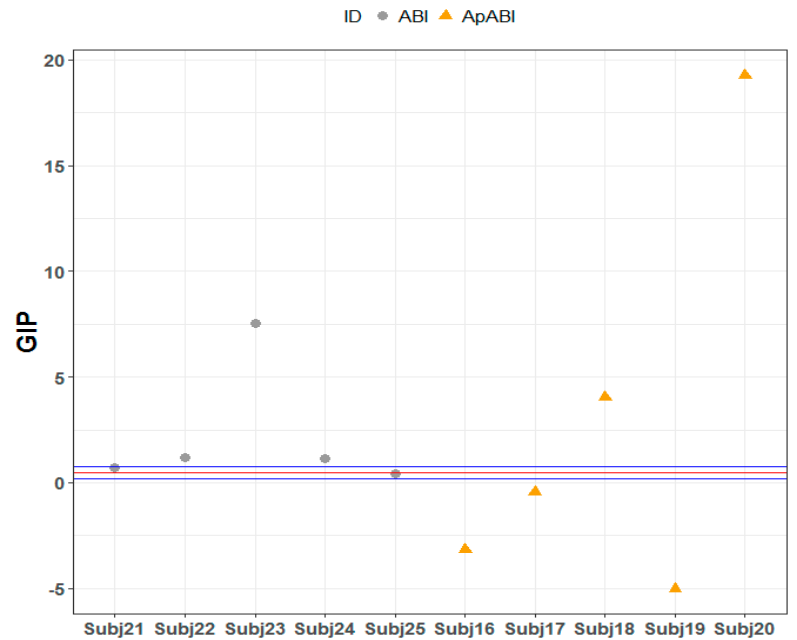
Figure 7. L-FT: GIP mean value of the difference between incongruent and congruent stimuli of each ABI patient, distributed above, below, or within the 95% confidence interval of control group. Red line = GIP mean value of the difference between incongruent and congruent stimuli of the control group; blue line = confidence limits, the two extreme values of the confidence interval which define the range.